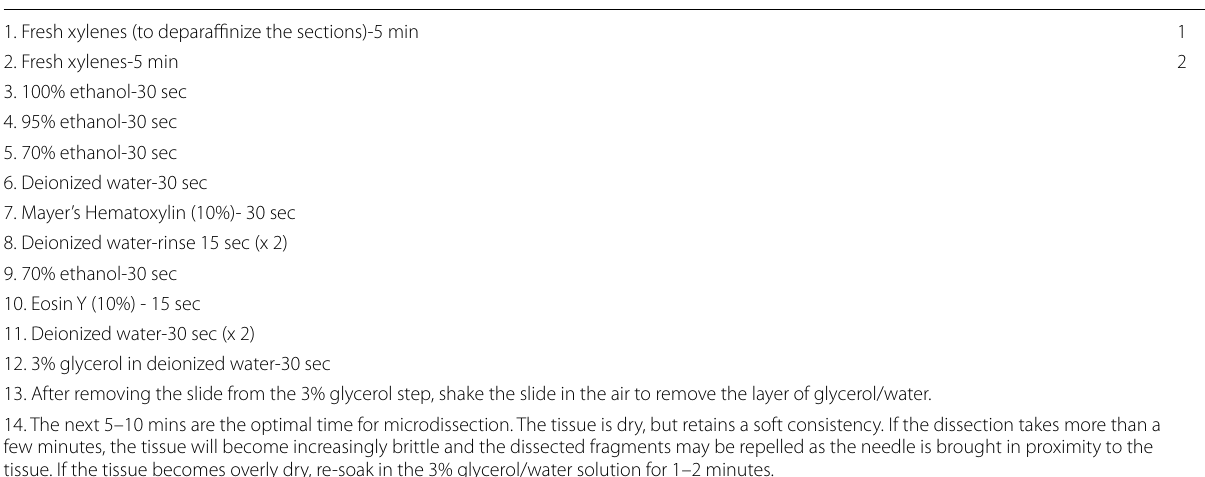
Table adapted from http:// www. proto col‑ online. org/ cgi‑ bin/ prot/ view_ cache. cgi? ID